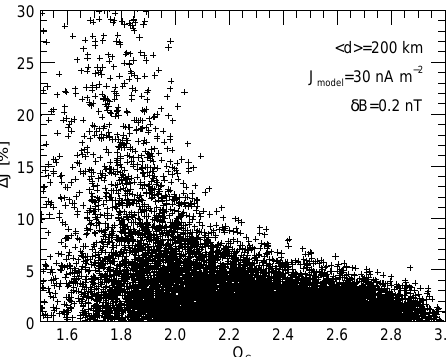
Figure 2. Relative error of the current density determination by the curlometer as a function of the tetrahedron’s quality factor.